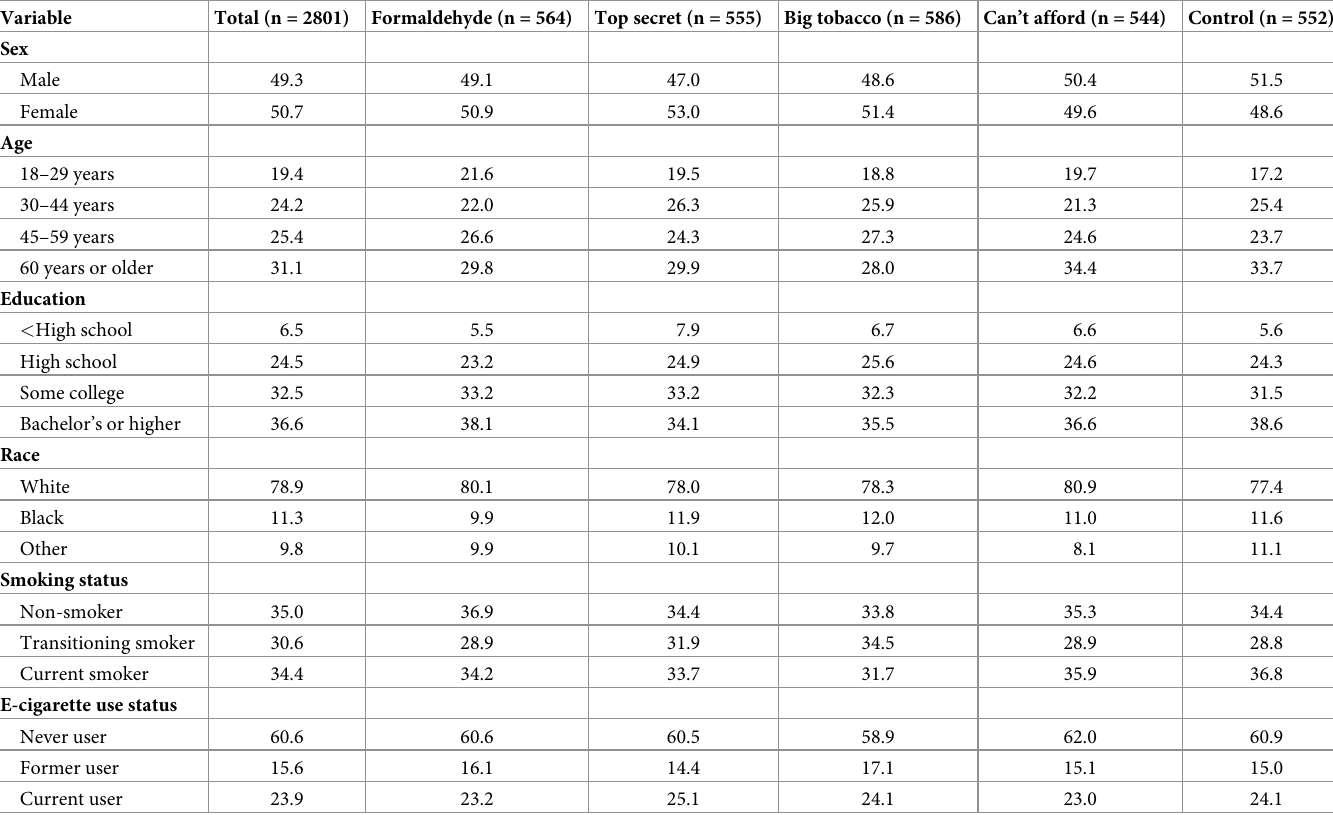
Table 2. Characteristics of study participants overall and by the message